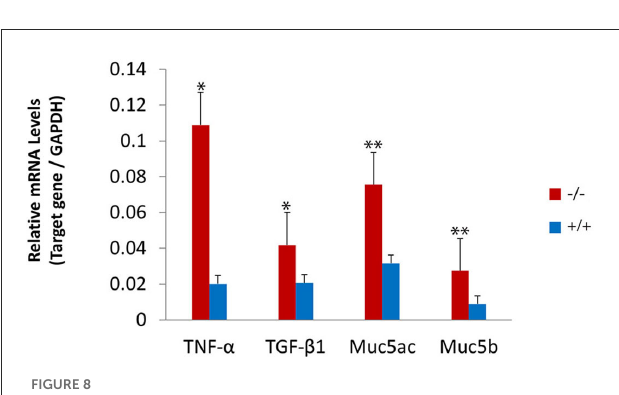
FIGURE8 Upregulated expression of the inflammatory-related gene in mutant mice. The levels of gene expression were evaluated in wild-type ( n = 3) and mutant mice ( n = 3) at the age of 7 months. The messenger RNA (mRNA) accumulation levels of tumor necrosis factor-alpha (TNF- α ), transforming growth factor-beta 1 (TGF- β 1), Muc5ac, and Muc5b were significantly higher in mutant mice than in wild-type mice. The error bar represents the standard error (SE) of the mean. * P < 0.05, ** P <